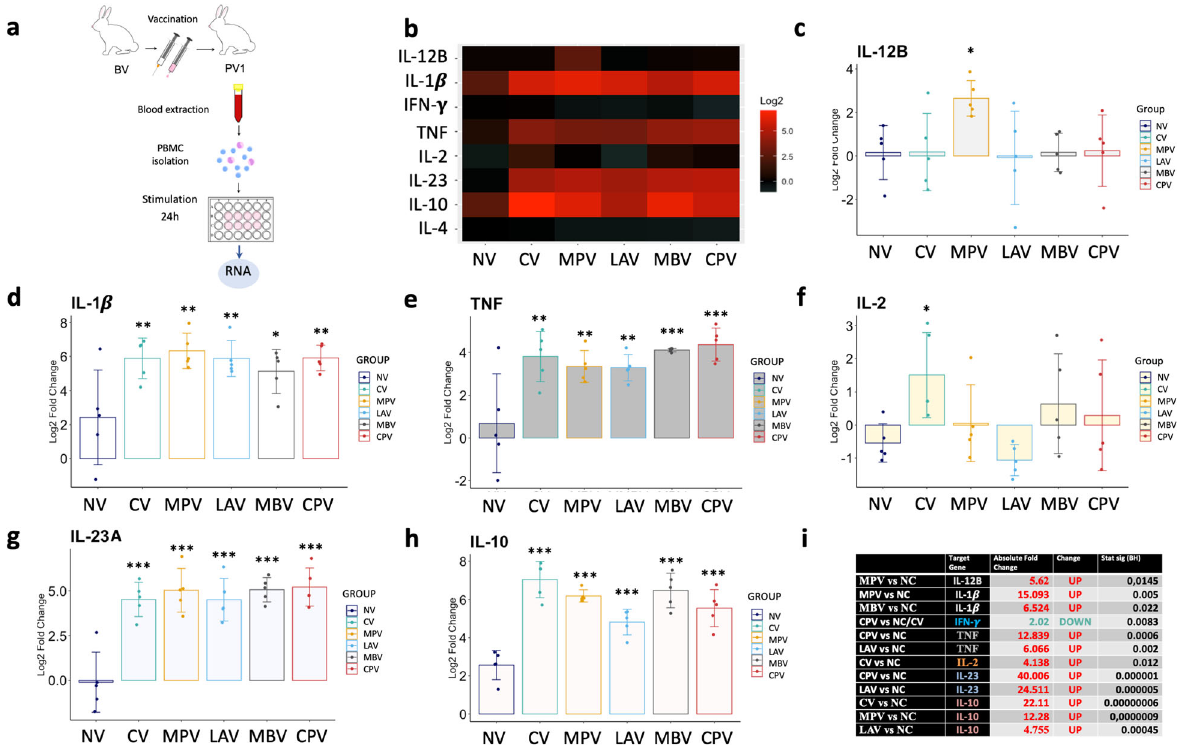
Fig. 8 Cytokine relative quanti fi cation by RT-qPCR in GALT at the end point of the experiment of all challenged groups relative to the NC. a Schematic representation of sample origin. b Heatmap representation of the average expression of cytokines; in red upregulated and in green downregulated gene expression. Bar charts showing log2 fold change between groups. c IL-12B, d IL-1 β , e TNF, f IL-2, g IL-23A, h IL-10, i Table summarizing signi fi cant differences between groups in cytokine expression and the Absolute Fold Change Factor. All values were means with error bars representing standard deviation from groups of n = 5, except for NC which was n = 4. ANOVA with Tukey ’ s post-host test was applied and signi fi cation levels are * p < 0.05, ** p < 0.01, ***<0.001. Table 1. Bacteriological analysis results of the control groups.